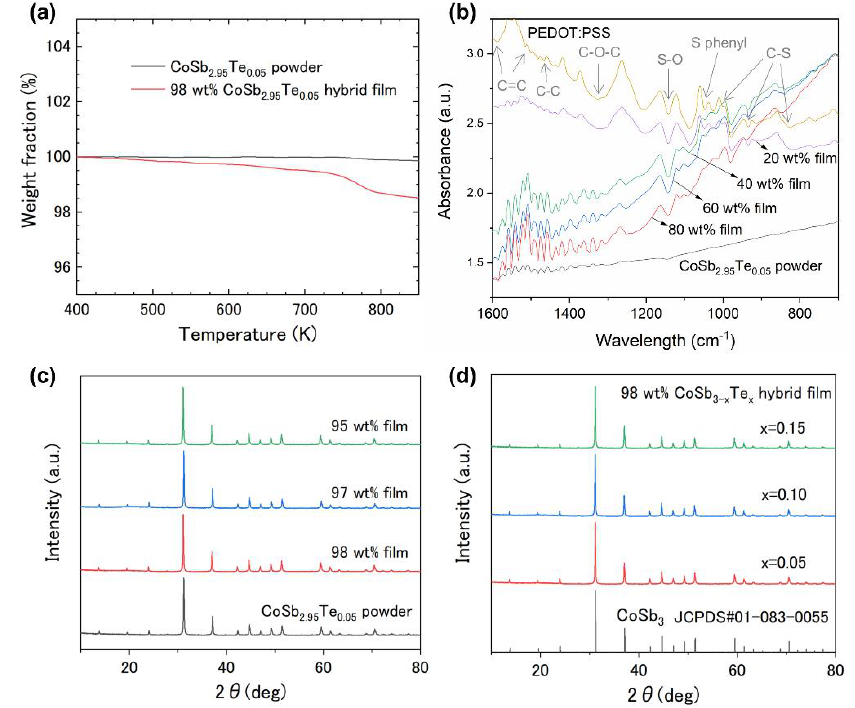
Figure 2. ( a ) TGA data of the 98 wt% CoSb 2.95 Te 0.05 hybrid film and the CoSb 2.95 Te 0.05 powder; ( b ) FT ‐ IR spectra of the pristine PEDOT:PSS film, the CoSb 2.95 Te 0.05 hybrid film (20, 40, 60, and 80 wt%), and the CoSb 2.95 Te 0.05 powder; ( c ) XRD patterns of the CoSb 2.95 Te 0.05 hybrid film (95, 97, and 98 wt%) and the CoSb 2.95 Te 0.05 powder; ( d ) XRD patterns of the 98 wt% CoSb 3 ‐ x Te x hybrid film with different amount of Te dopants (x = 0.05, 0.10, and 0.15).